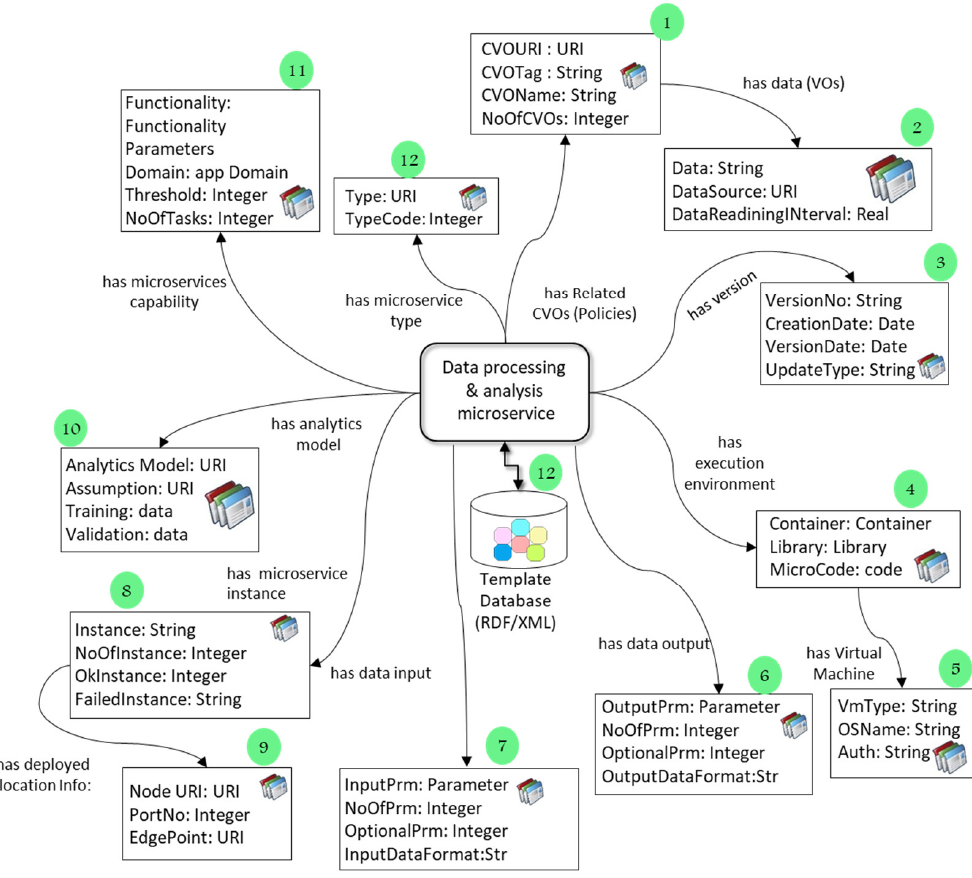
Figure 4. Microservice template’s information model to create and discover microservices for BEEMS.